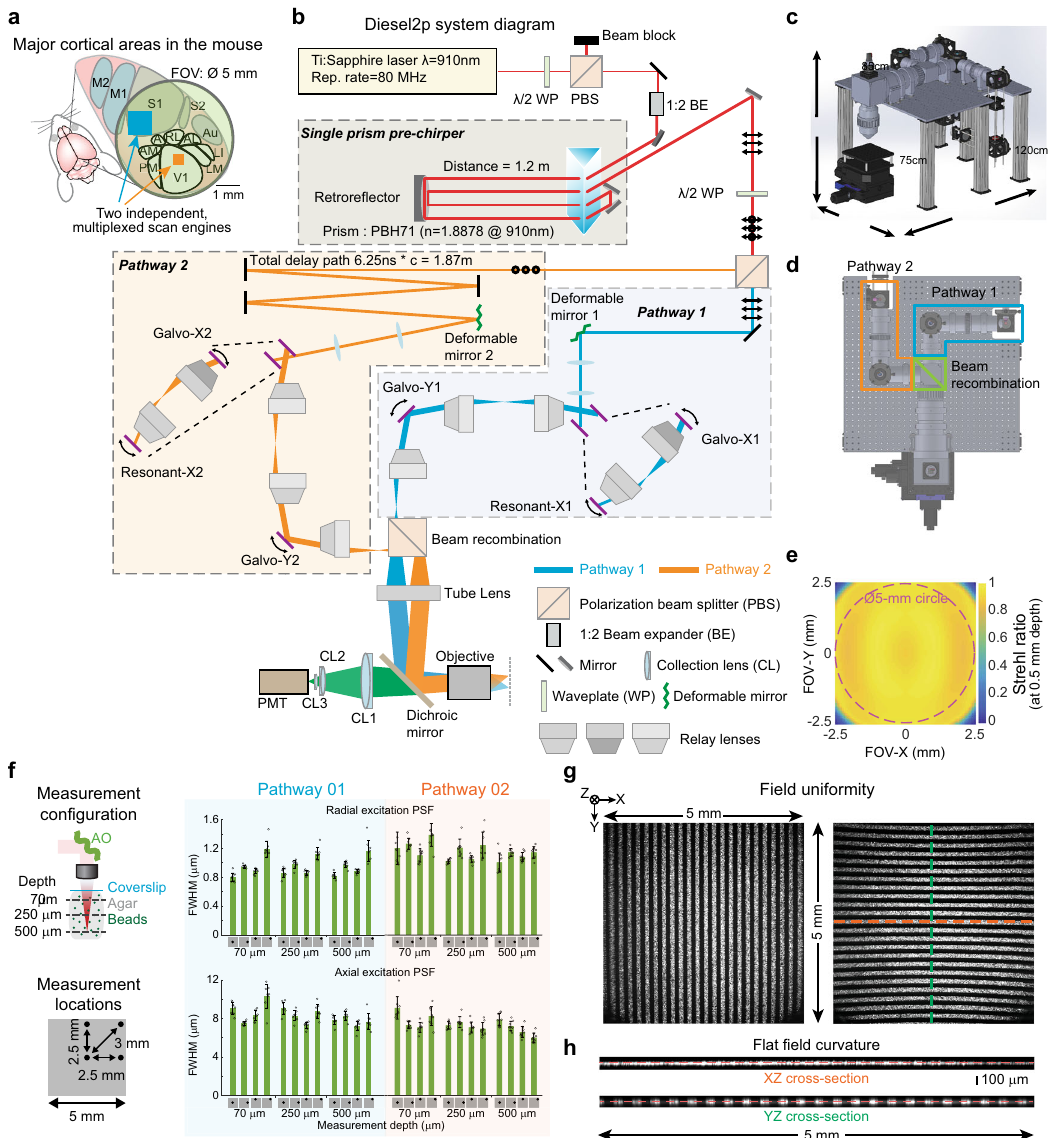
Fig. 1 Diesel2p system features, layout, and performance benchmarks. a Functional cortical areas in the mouse brain are widely distributed. A fi eld-of- view (FOV) of Ø5mm can encompass multiple brain areas, and independent scan engines can capture ongoing neural activity in multiple cortical areas simultaneously with optimized scan parameters. b Two imaging beams are temporally multiplexed and independently positioned in XY using two sets of resonant-galvo-galvo scan engines. First, overall power is attenuated using a half-wave plate ( λ /2 WP) and a polarizing beam splitting cube (PBS). A 2X beam expander (1:2 BE) enlarges the beam for the clear aperture of the deformable mirrors adaptive optics (AO). A custom single-prism pre-chirper offsets system dispersion to maintain transform-limited pulses at the focal plane. A second λ /2 WP and PBS pair divides the beam into two pathways. Pathway 2 (s-polarization in orange) passes to a delay arm where it travels 1.87 m further than Pathway 1 using mirrors, thus delaying it by 6.25 ns relative to Pathway 1 (p-polarization in blue). Both pathways each proceed to deformable mirrors for adjusting the focal plane and correcting optical aberrations before being directed to resonant-galvo-galvo scan engines. All scanning mirrors are optically relayed to each other. Each pathway then passes through a scan lens before being combined with a beam recombination relay. A tube lens and an infrared-re fl ective dichroic mirror relay the two multiplexed beams onto the back aperture of the objective. Fluorescence (green) is directed to a photomultiplier tube (PMT) via an assembly of collection lenses (CL1, CL2, CL3). c An oblique view of a 3-D model of the system and its footprint. d A top view with the arrangement of the two scan engines highlighted. e Plot of the model Strehl ratio across the scan area indicates diffraction limited performance (Strehl ratio > 0.8) across ~25 mm 2 , signi fi cantly larger than the area of the dashed 5-mm diameter circle (~19.6 mm 2 ) by ~28%. f Multiphoton excitation PSF measurements were made with subresolution beads (0.2 µ m) in agar under a coverslip at three depths and four locations, for both of the AO-equipped, temporally multiplexed beam pathways. FWHM of the Gaussian fi ts for measurements from the fl uorescence beads radially and axially are calculated and plotted. Eight beads ( n = 8) at each locations are measured, except that there are 7 beads ( n = 7) measured on axis at the depth of 500 µ m. Data are presented as mean values± S.D. g XY images of a calibrated, structured fl uorescent sample with a periodic line pattern (5 lines per millimeter) in two orientations acquired under the full scan range of the system. Each image shows 25 lines on the top edge (left image) and on the left edge (right image), receptively, verifying a 5 × 5 mm FOV. h The XZ image along the orange dashed line and the YZ image along green dashed line in ( g ) are also plotted. The imaging pattern is colinear with the straight lines, suggesting a fl at fi eld both in x and y directions across the